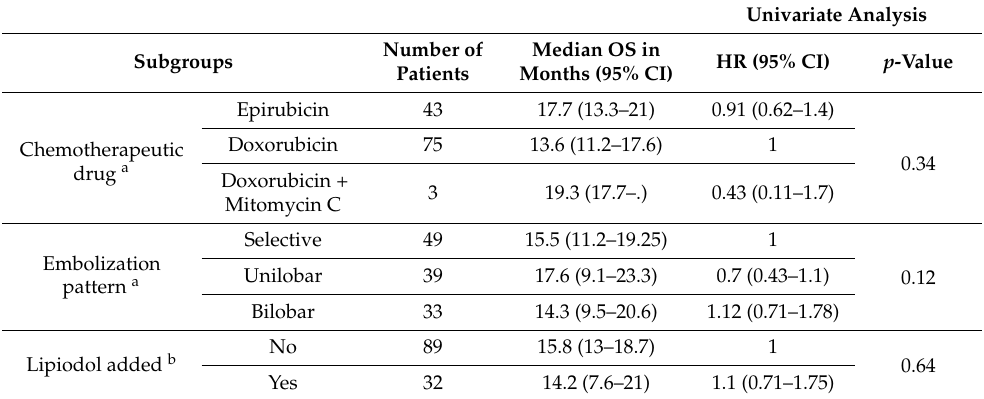
Table 4. Survival analysis of treatment properties.